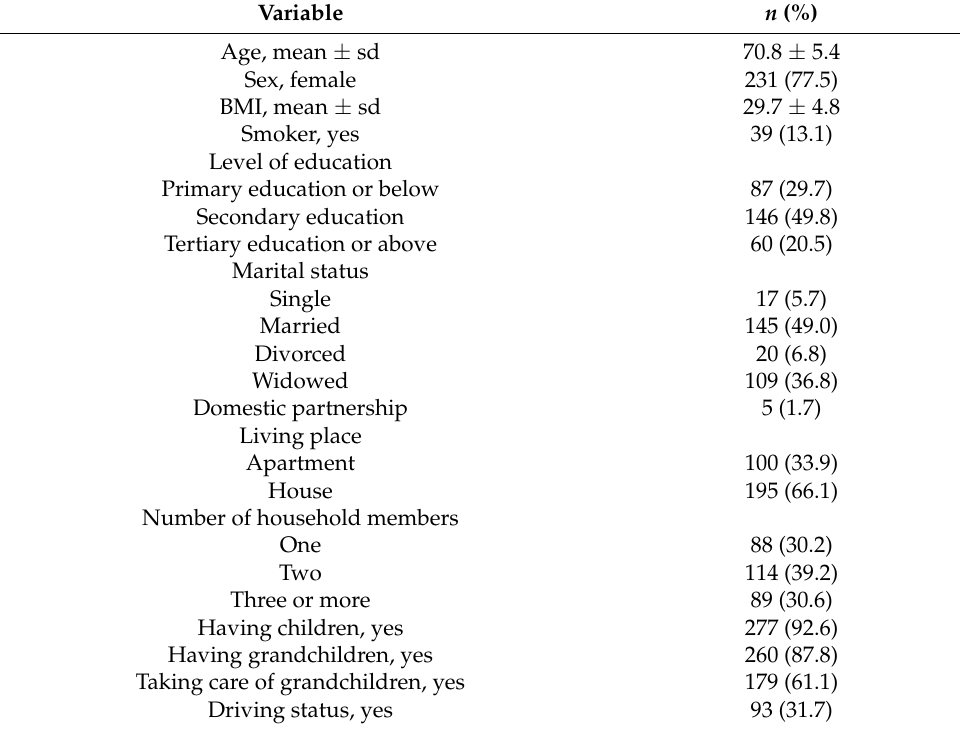
Table 1. Sociodemographic characteristics of the study